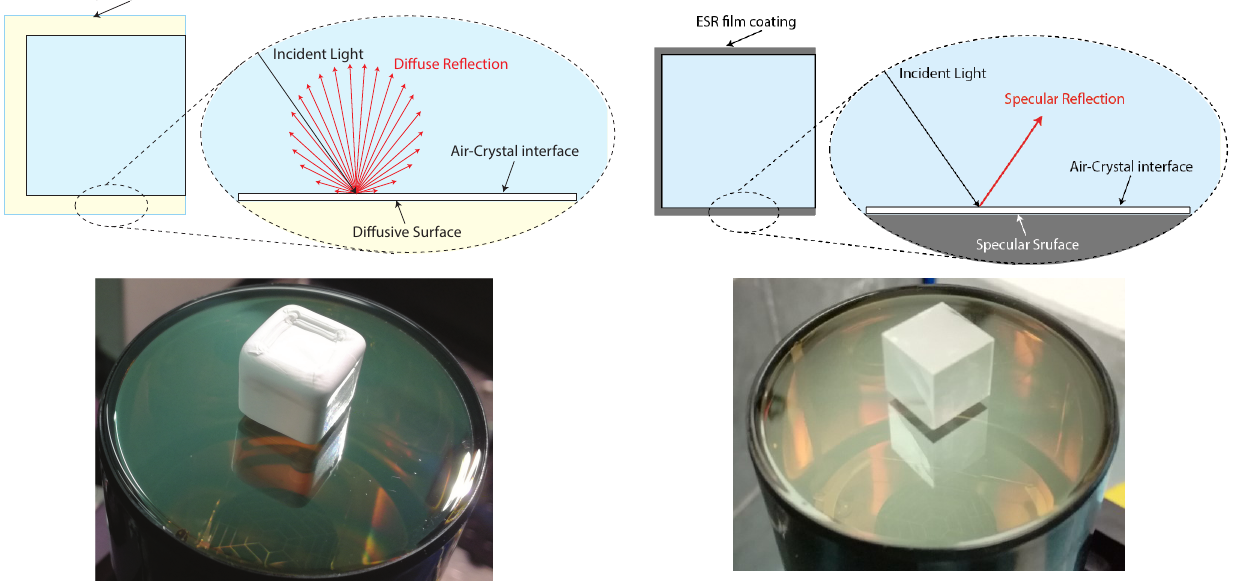
Figure 3. Typical scintillator wrapping examples. ( Left ): Teflon (diffusive) wrapping vs. ( Right ): ESR (specular) wrapping. ( Top row ): Schematic representation, ( Bottom row ): Actual crystals attached to the window of a Photomultiplier Tube